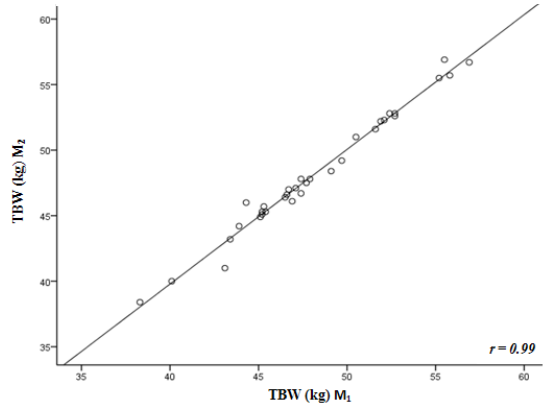
Figure 4. Correlation between the values of param- eters measured by Tanita before and after the intake of fluids – total body water (kg)